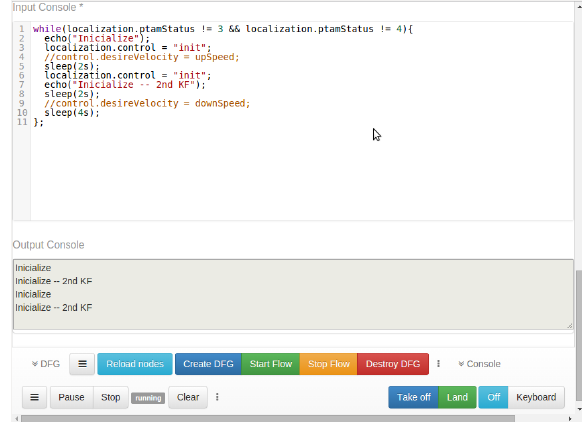
Figure 3. Urbiscript console. On the top – script editor, middle – output of executed script, bottom left – script execution control (surrounded with other controls of X-Copter